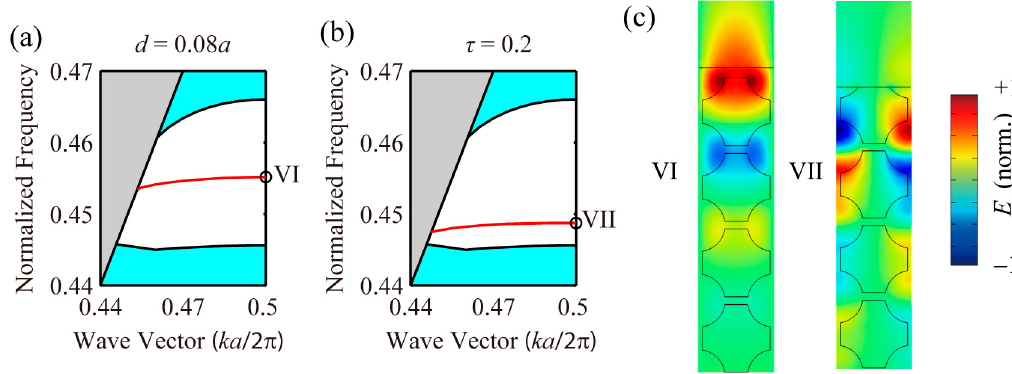
Figure 13. Dispersion curves of the surface wave bands of photonic odd mode, where the geometrical parameters are r = 0.35 a , w = 0.9 a , t = 0.4 a , d = 0.04 a ( a ), and τ = 0.2 ( b ), respectively. The cyan and gray areas represent the projected bulk modes and light cone, respectively. ( c ) Electric field ( E Z ) distributions at plane z = 0 corresponding to different photonic surface bands.